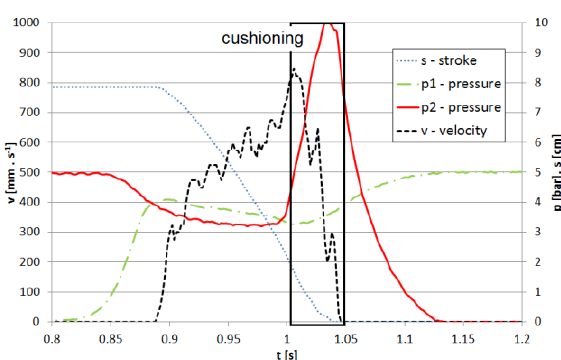
Fig. 5. Course of the pressure and velocity during cushioning Similarly works so-called self-adjusting cushioning.